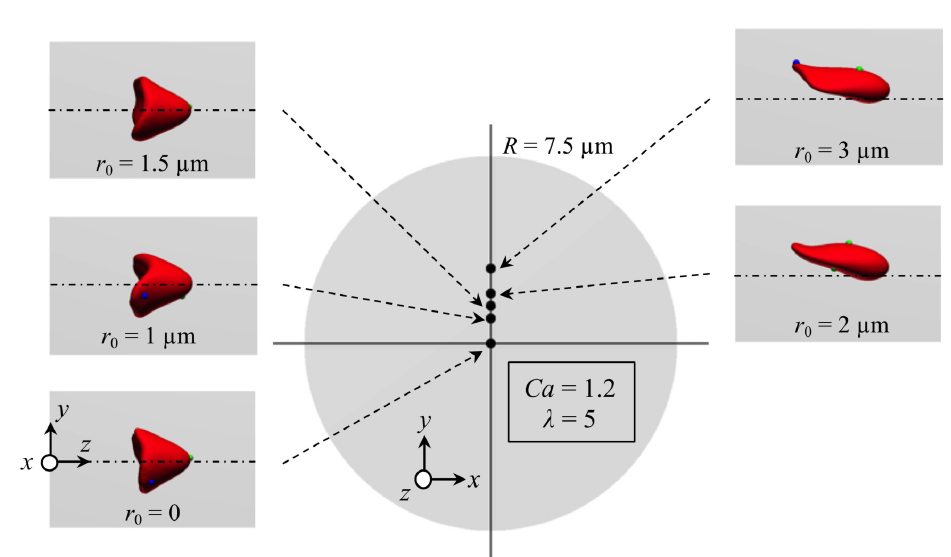
Figure A2. Snapshots of flowing RBCs in steady state at Ca = 1.2 for different initial positions r 0 (0, 1 µ m, 1.5 µ m, 2 µ m, and 3 µ m). The results were obtained with Re = 0.2 and λ = 5.